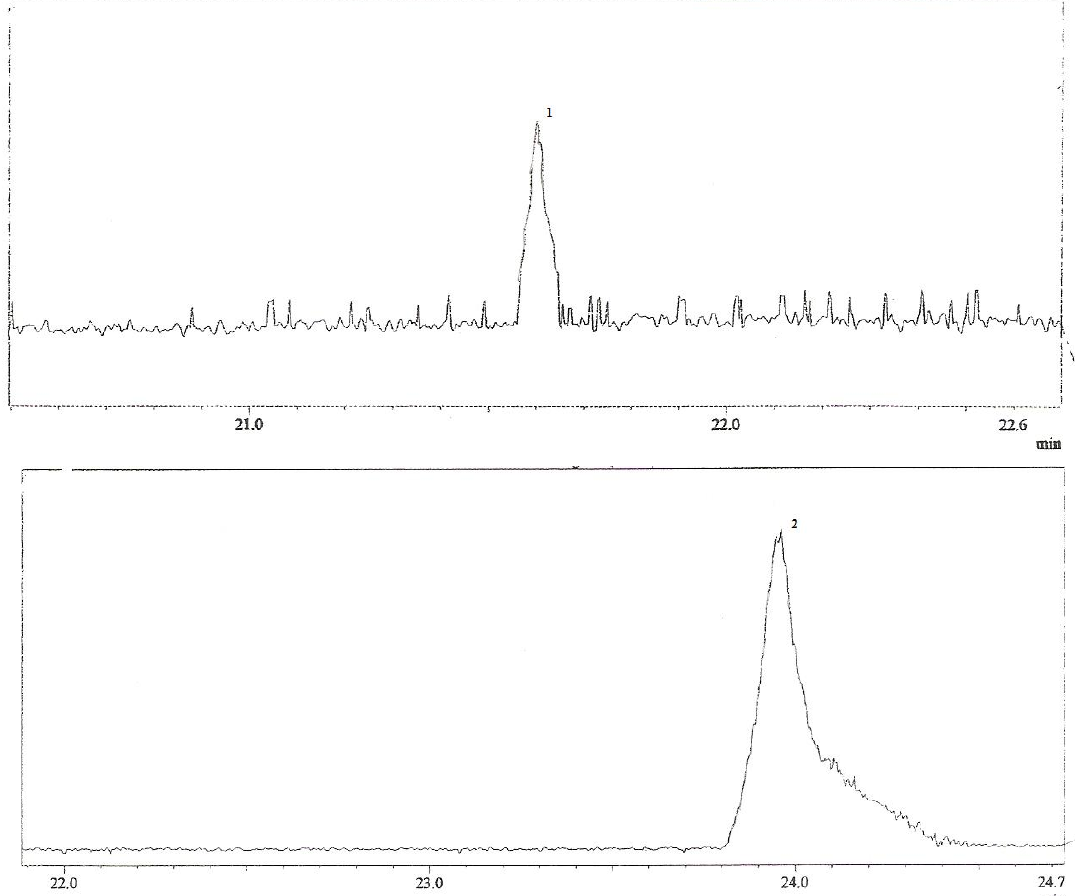
-methylvoachalotine ( 2 b